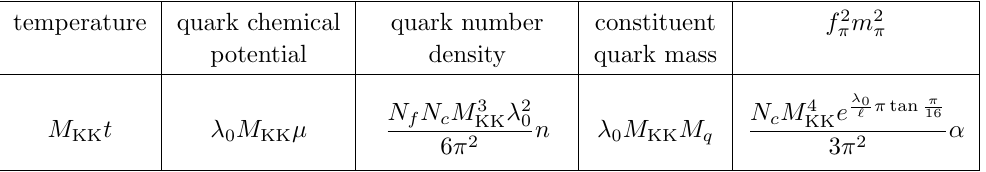
Table 1 . How to obtain the physical, dimensionful quantities from their dimensionless counterparts t , (cid:22) , n , M q , (cid:11) that are used in the calculation. In all plots in section 4 we use an additional rescaling with the asymptotic separation of the (cid:13)avor branes, ~ t = t‘ , ~ (cid:22) = (cid:22)‘ 2 , ~ n = n‘ 5 , ~(cid:10) = (cid:10) ‘ 7 , ~ M q = M q ‘ 2 , ~ (cid:11) = (cid:11)‘ 4 , ~ (cid:21) = (cid:21)=‘